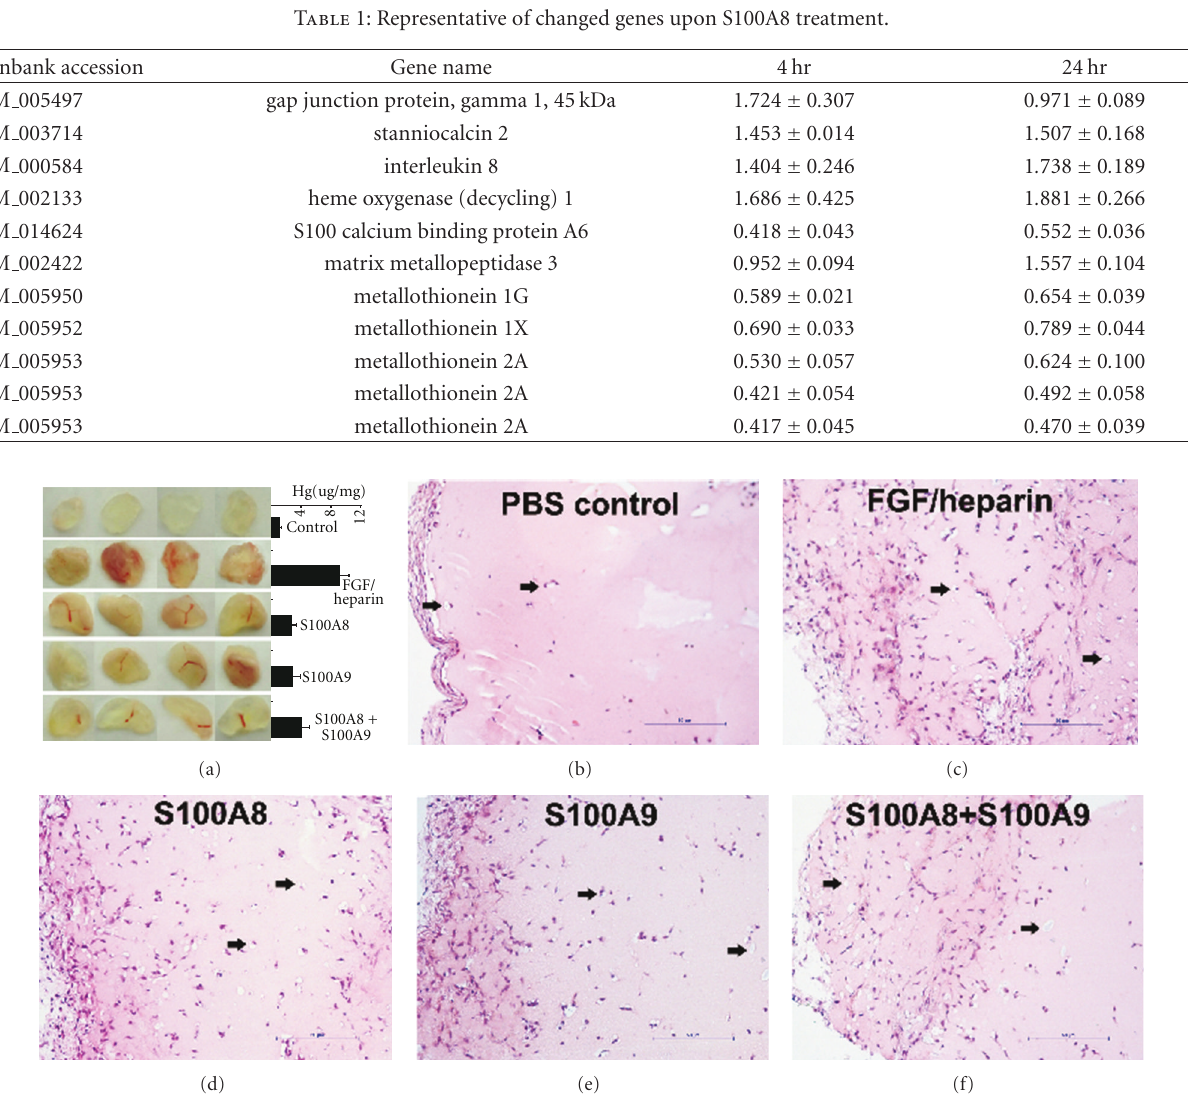
Figure 4: Photographs (pictures, upper left panel), haemoglobin contents (solid columns, upper left panel), and histology of Matrigel plugs indicating increased neovascularization following S100A8 or S100A9 protein treatment. Matrigel mixed with PBS was the negative control group, and FGF plus heparin was the positive control group. Haemoglobin content of Matrigel plugs (mean ± standard deviation, n = 4) was expressed as the amount of haemoglobin per gram of Matrigel plug. Microscopic examination of the same Matrigel plugs showed inflammatory cells and vascular structures (arrowheads). Shown are representations of two experiments with similar